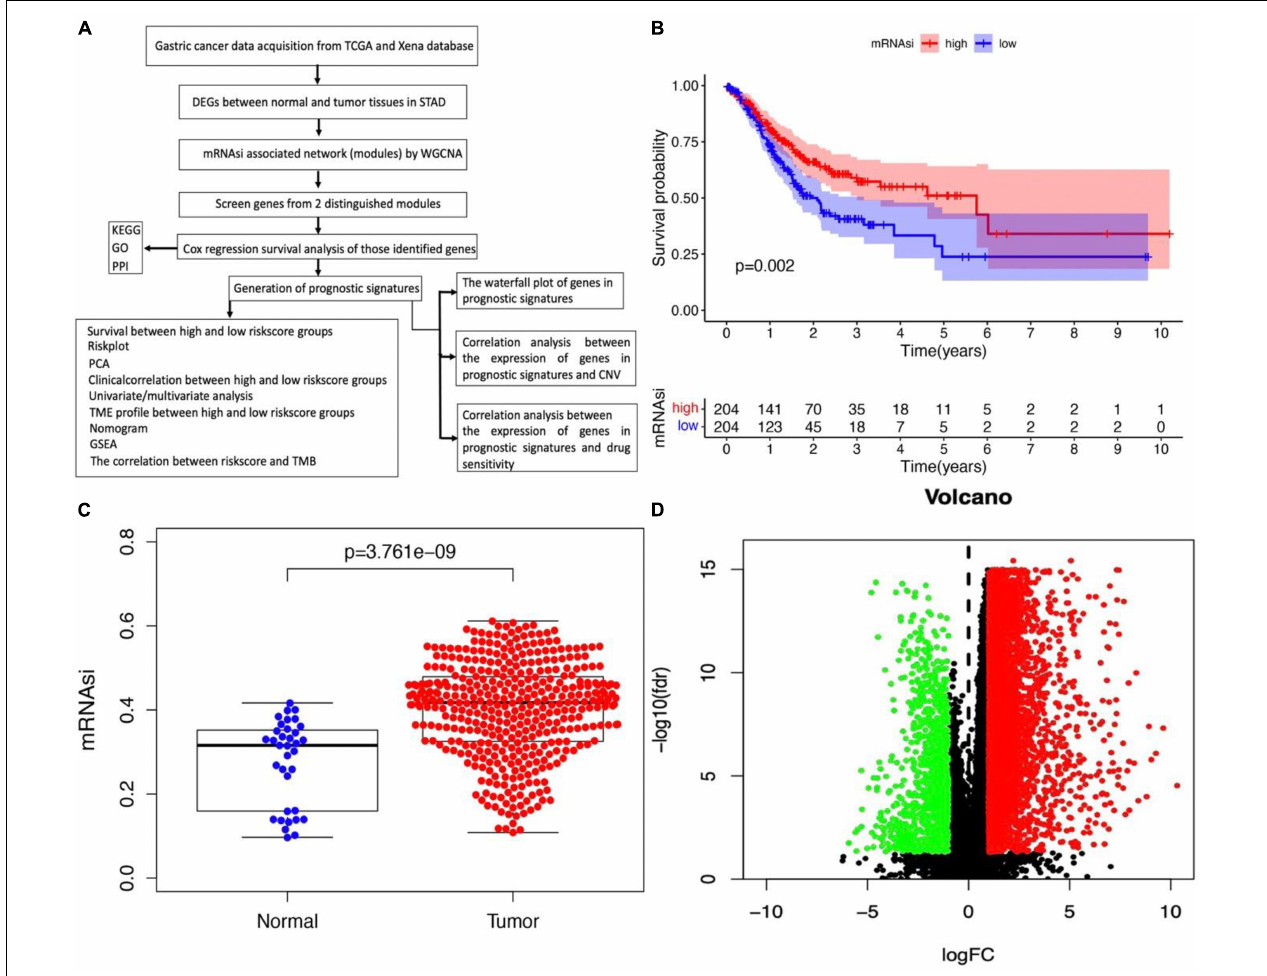
FIGURE 1 | Identification of DEGs betweennormal and tumor tissues in STAD. (A) The flow chart for identification of mRNAsi related signature in STAD. (B) Kaplan–Meier curves show that the low mRNAsi group had greater mortality than the high mRNAsi group. (C) Differences in mRNAsi between normal and tumor tissues in STAD. (D) Identification of DEGs between normal and tumor tissues in STAD; green and red indicate downregulated and upregulated genes,